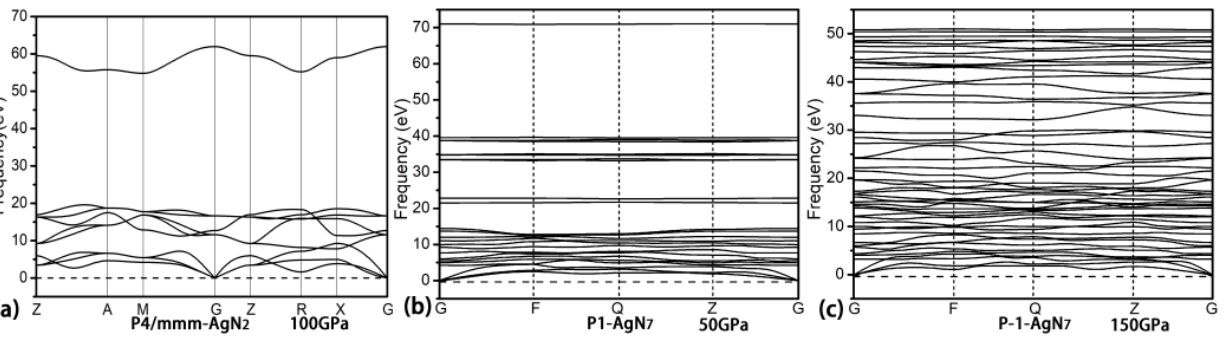
Figure 1. The formation enthalpies of Ag-N phases with respect to the Abma-AgN phase and nitrogen solids at different pressures ( a – c ). Figure ( d ) shows the phase diagram of AgN 2 and AgN 7 .